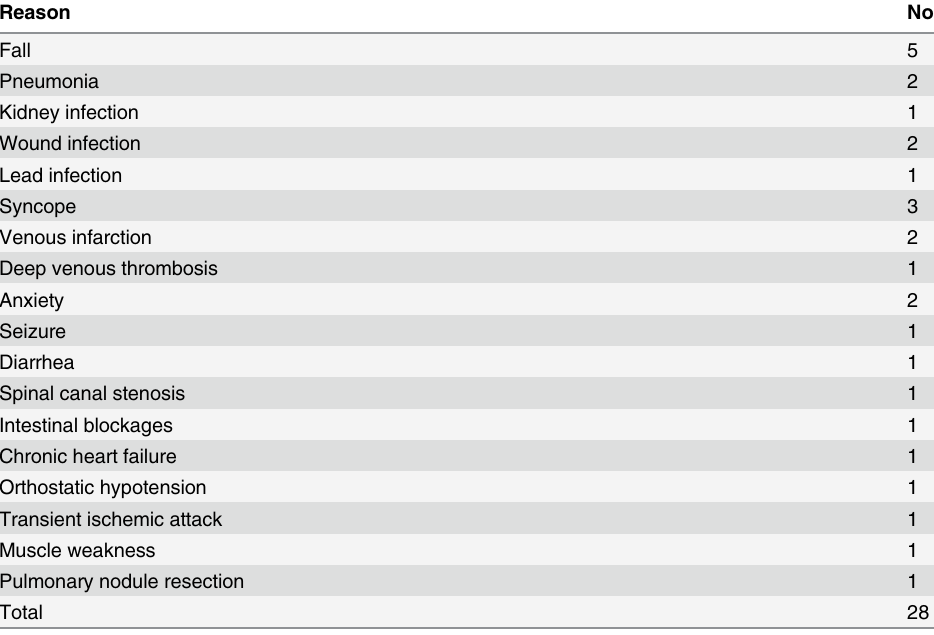
Table 4. Primary reasons of reported unintended hospitalizations following DBS surgery.